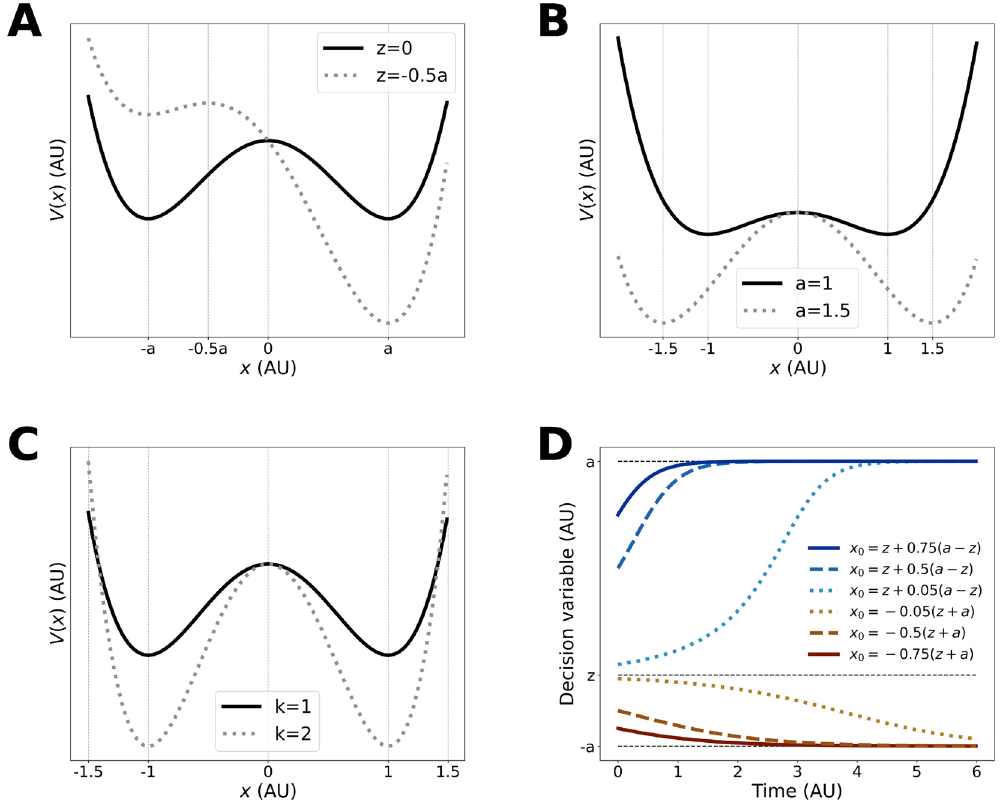
Figure 2. Parameter manipulation on the nl-DDM. ( A – C ) Potential functions of the nl-DDM for different z ( A Shifting z changes the relative attractiveness of each boundary, a ( B Shifting a changes the accuracy and the speed of decisions), and k ( C Shifting k changes the speed of decisions). The parameters are always the same for the solid black curve: a = 1, k = 1, z = 0 , allowing for a comparison of the effects of the different parameters. ( D ) Trajectories in the absence of noise for different values of x 0 , under a = 1, k = 1, z = 0 . It becomes clear that the drift range for each trajectory depends on the starting point. The trajectory approaches the boundary asymptotically and will eventually be crossed since noise is omnipresent.